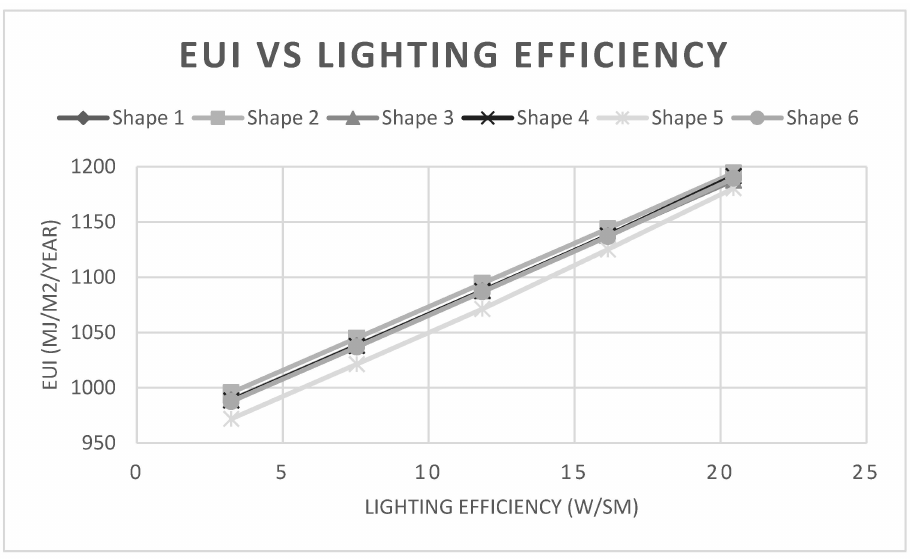
Figure 11. EUI of shapes vs. lighting